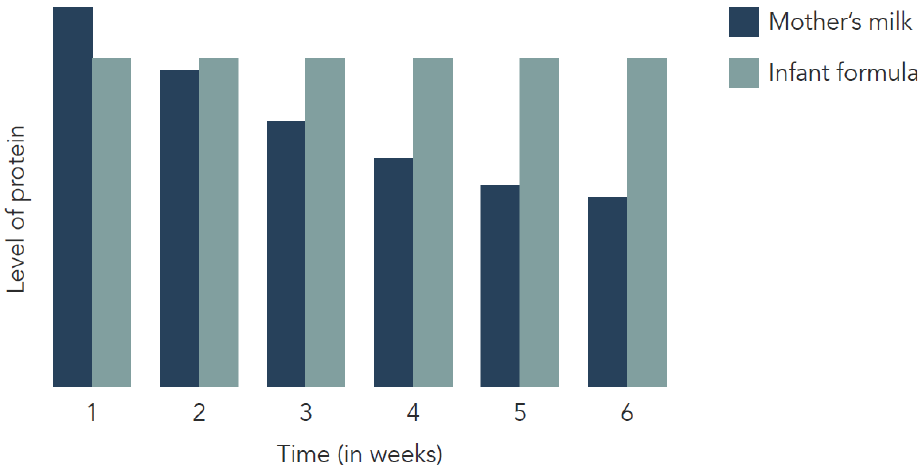
Figure 1. Protein concentrations of infant formula and breast milk over time (schematically).